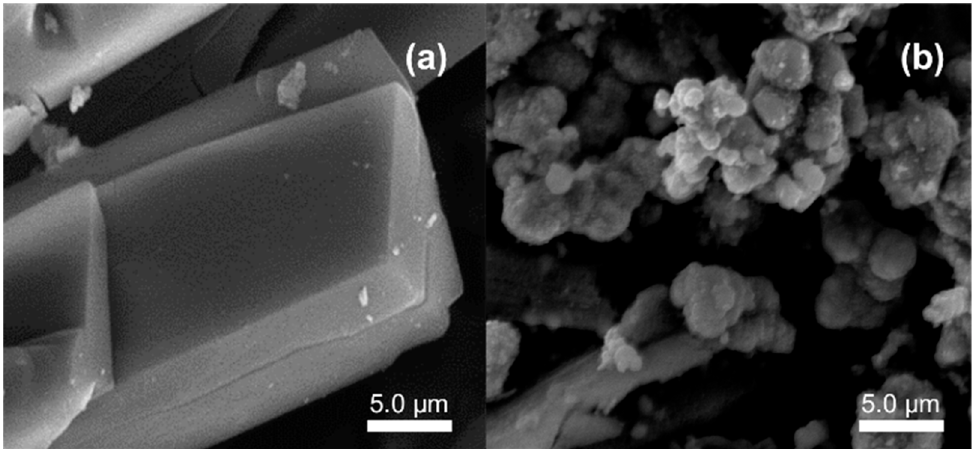
Figure 4. Scanning Electron Microscopy (SEM)images of ( a ) FeBDC ( b ) FeBDC-derived Fe 3 O 4 .